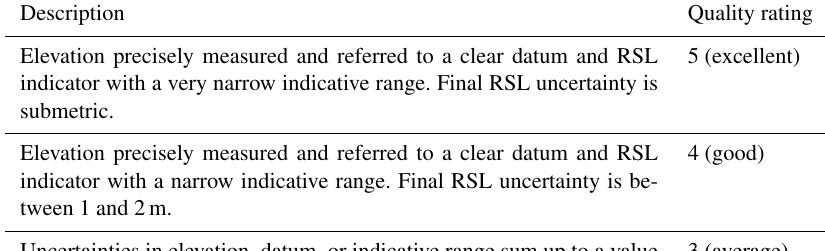
Table 4. Quality rating guidelines used for evaluating RPSLs. Exported from WALIS (Rovere et al., 2020). Description Quality rating Elevation precisely measured and referred to a clear datum and RSL